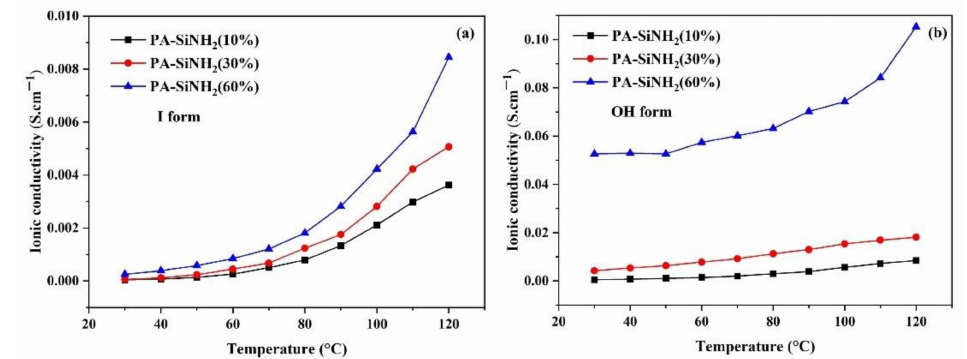
Figure 1. Conductivity of MPK–SiN membranes with different weight loadings of modified silica (10–60%) in: ( a ) I form; ( b ) OH form as a function of